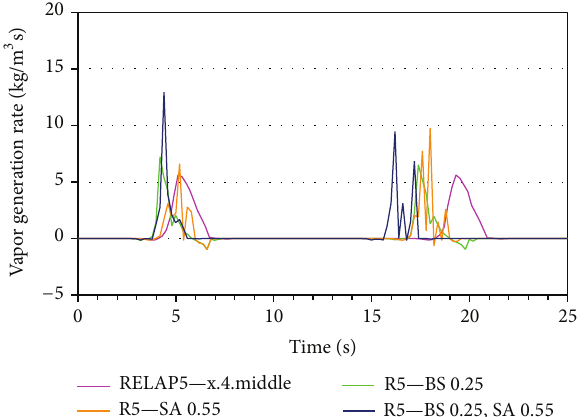
Figure18:Vaporgenerationrateattheriserobservationsectionpre-